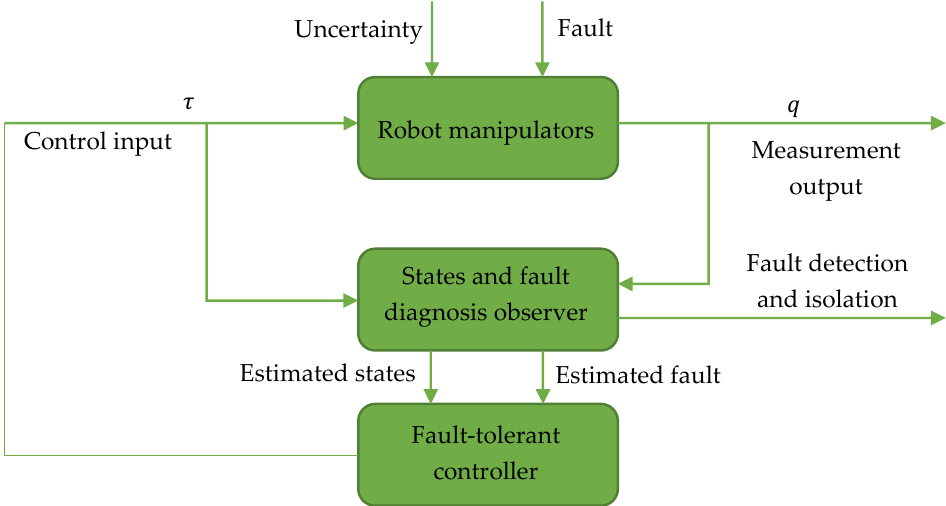
Figure 6. Block diagram of the method presented by Mien Van, Pasquale Franciosa, and Dariusz Ceglarek [36].